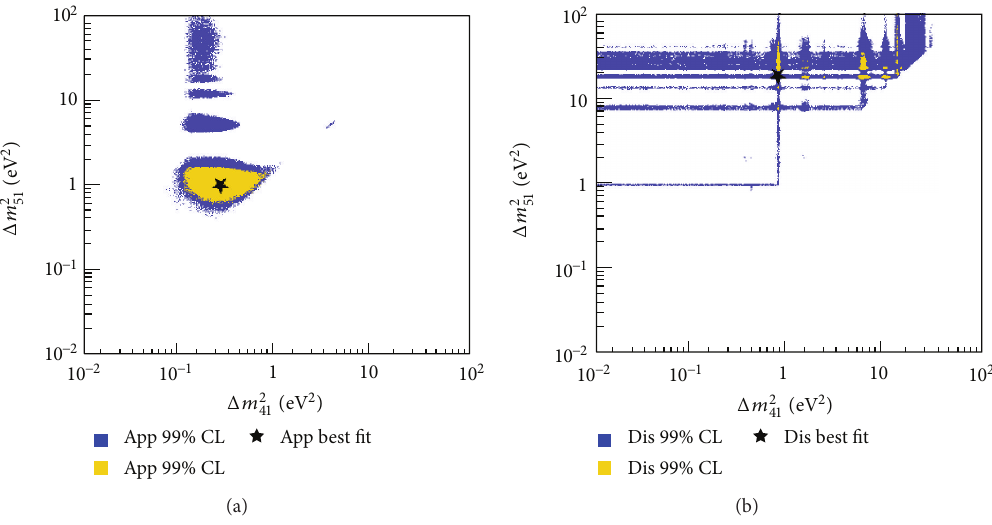
Figure 9: The Δ𝑚 2 51 versus Δ𝑚 2 41 allowed space from fits to appearance (a) and disappearance (b) data in a ( 3 + 2 )